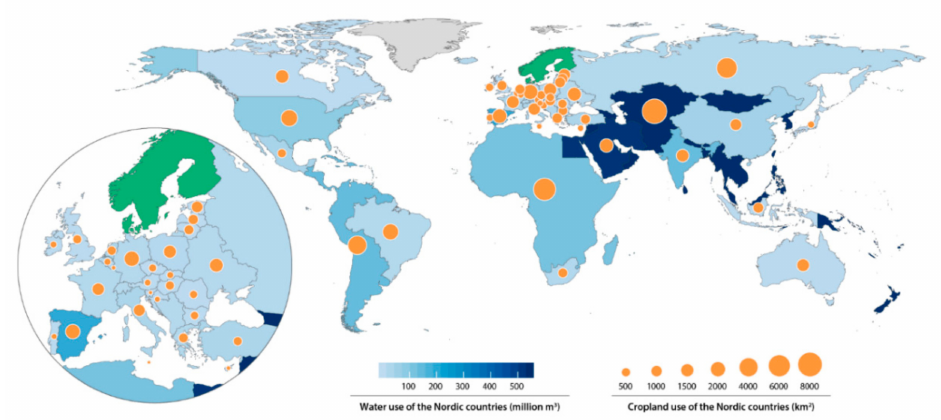
Figure 2. The use of cropland and water outside the Nordic countries as a result of current Nordic food consumption. Originally printed in [36]. Reprinted with permission from Stockholm Resilience